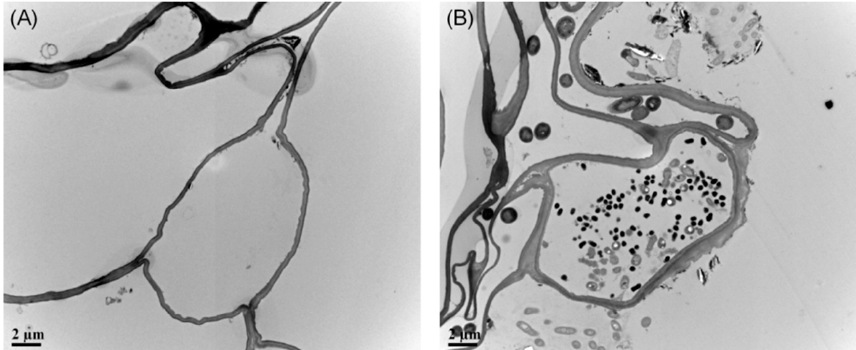
Figure 1. Morphology of wheat roots under transmission electron microscope: ( A ) wheat roots not inoculated with salt-tolerant plant growth promoting rhizobacteria (ST-PGPR) and ( B ) wheat roots inoculated with ST ‐ PGPR.